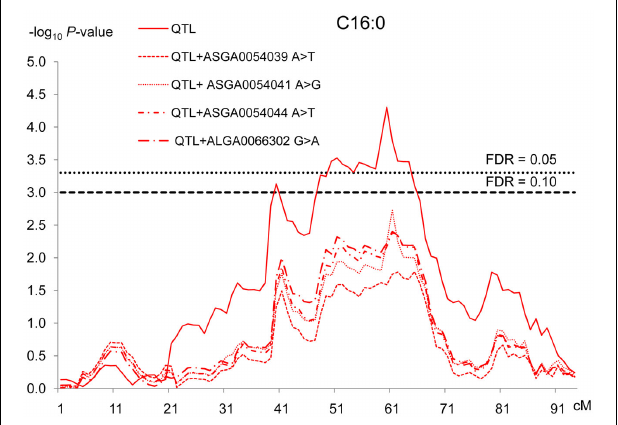
FIGURE 4 | QTLs significance profiles for C16:0 fatty acid across SSC12 using different models. For each test, on the y -axis are − log 10 of P -values and on the x -axis, the position in cM. Each line represents one QTL test using a different model.The continuous red line represents the test using a model of one QTL and the different red dash lines represent different tests using the model of marker-assisted association with four SNPs, three of them located within PCTP gene ( ASGA 0054039T > C, ASGA 0054041A > G, ASGA 0054044A > T) and one in ACACA gene ( ALGA 0066302G >